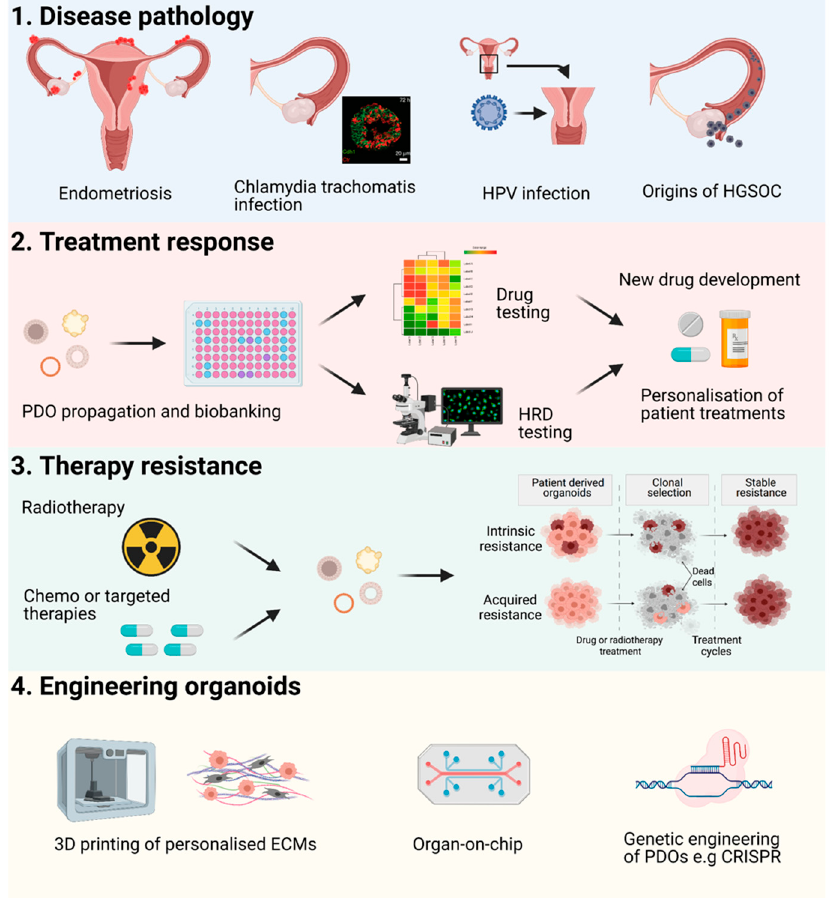
Figure 2. Overview of the applications of organoids in the research of gynaecological malignancies. 1. Organoids can model different cell processes and disease pathology such as endometriosis, bac- terial infections such as Chlamydia trachomatis , HPV infection leading to cervical cancer, and inves- tigating the origins of HGSOC. 2. PDOs can also be propagated for long-term biobanking for future regeneration. PDOs are amenable to drug screening to mimic patient drug responses to guide per- sonalisation of therapy or improve pharmaceutical drug discovery rates. Assays to assess homolo- gous recombination capacities of PDOs can also be performed. 3. PDOs can also be used to model